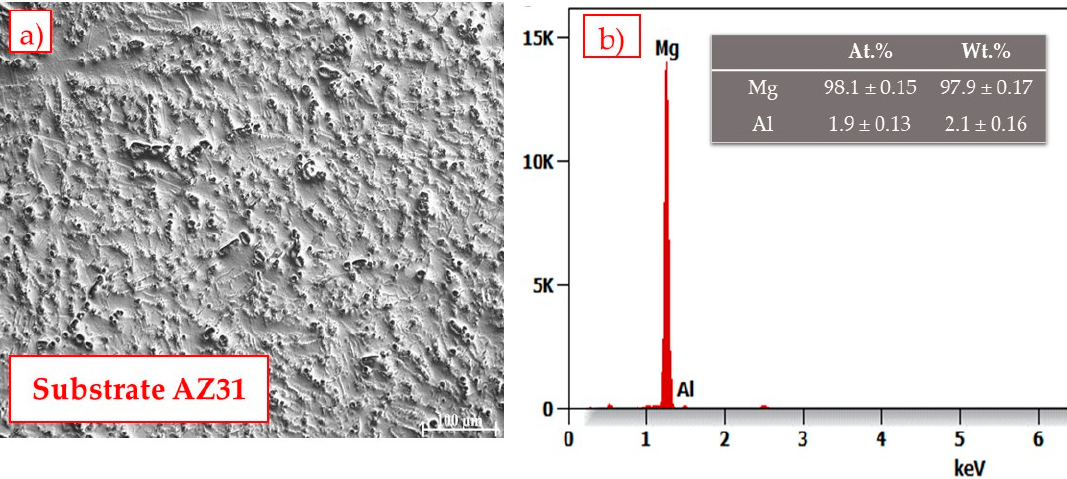
Figure 1. Cross-section image of the substrate ( a ) and the EDS analysis of the substrate ( b ). The chemical composition of the feedstock powders that were used in the coating manufacturing process is given in Table 1